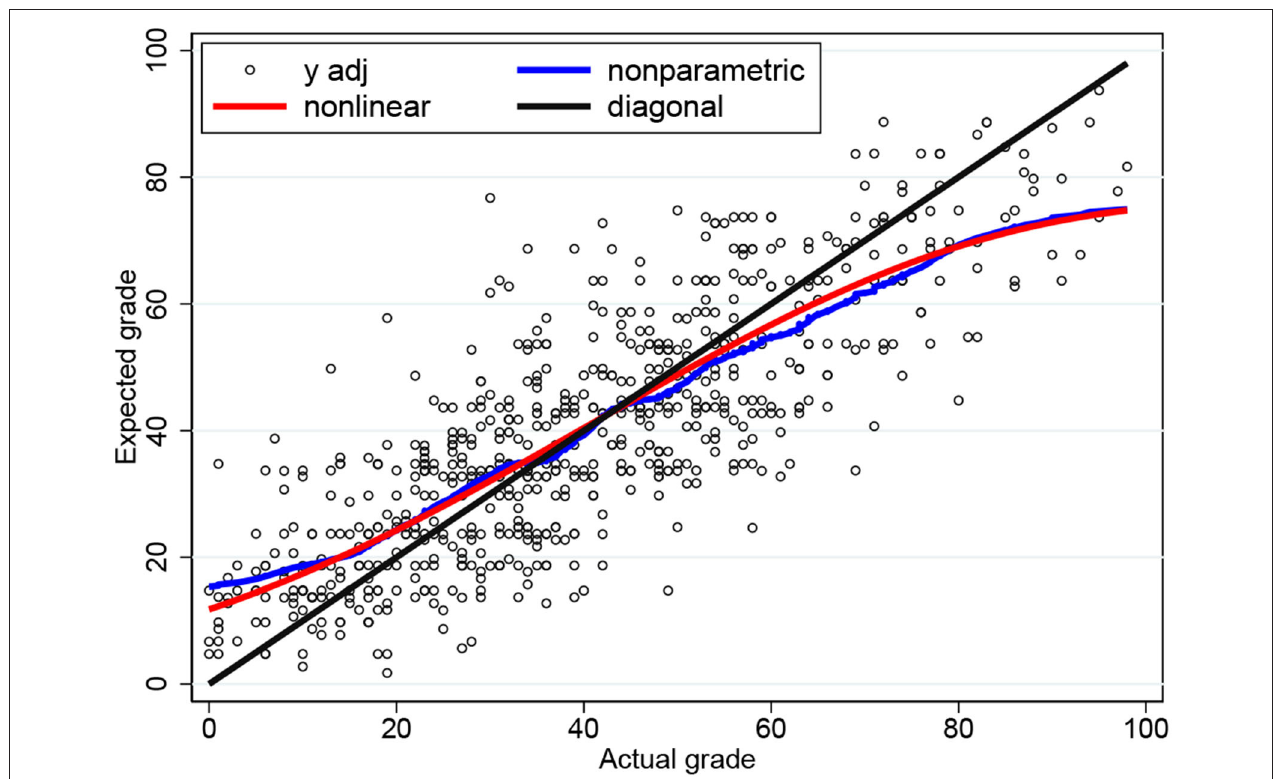
FIGURE 4 | Conditional expectation functions for the three-parameter censored tobit model based on NLS and nonparametric estimates.